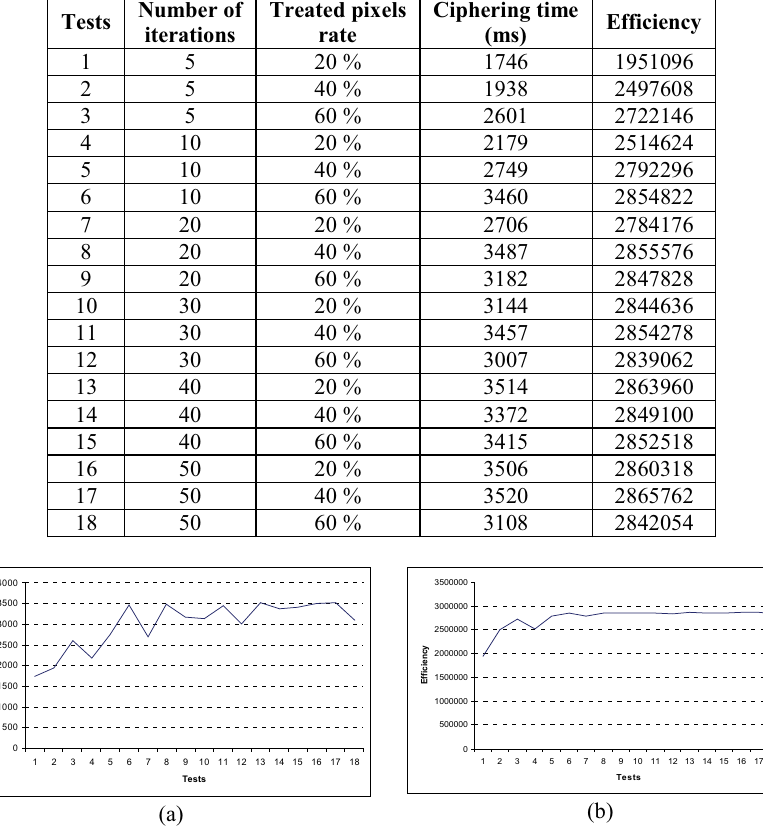
Fig. 8. (a) Variation of S2CA-EX ciphering time through the performed tests, (b) Variation of efficiency through the performed tests.